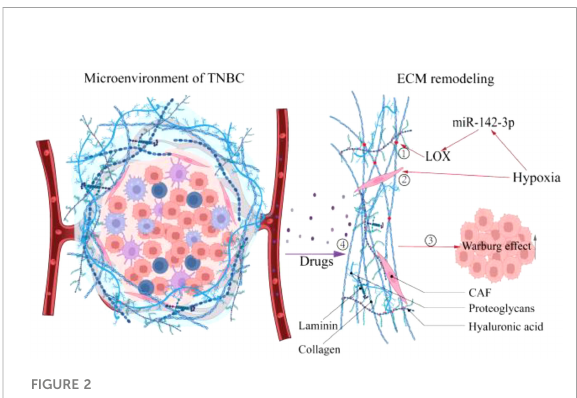
FIGURE 2 Hypoxia promotes the ECM remodeling. Hypoxia causes ECM remodeling, which affects tumor progression further. ① Enhanced matrix cross-linking. ② Local compaction and distant stretching of matrix fi bers derived from CAFs-mediated contractile forces. ③ ECM remodeling promotes the Warburg effect. ④ ECM stiffness prevents drug penetration. LOX, Lysyl oxidase; CAF, Cancer- associated fi